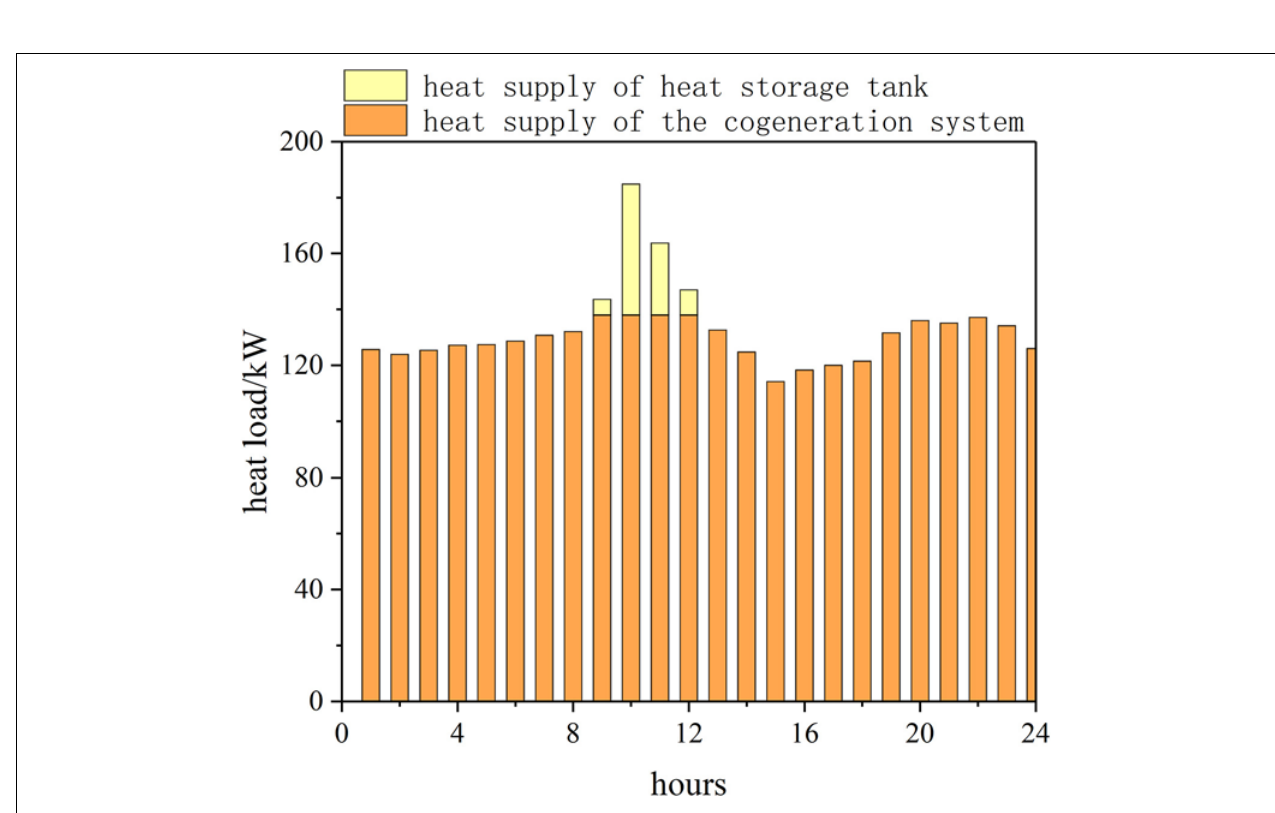
FIGURE 3 | Thermal energy supply on a typical winter